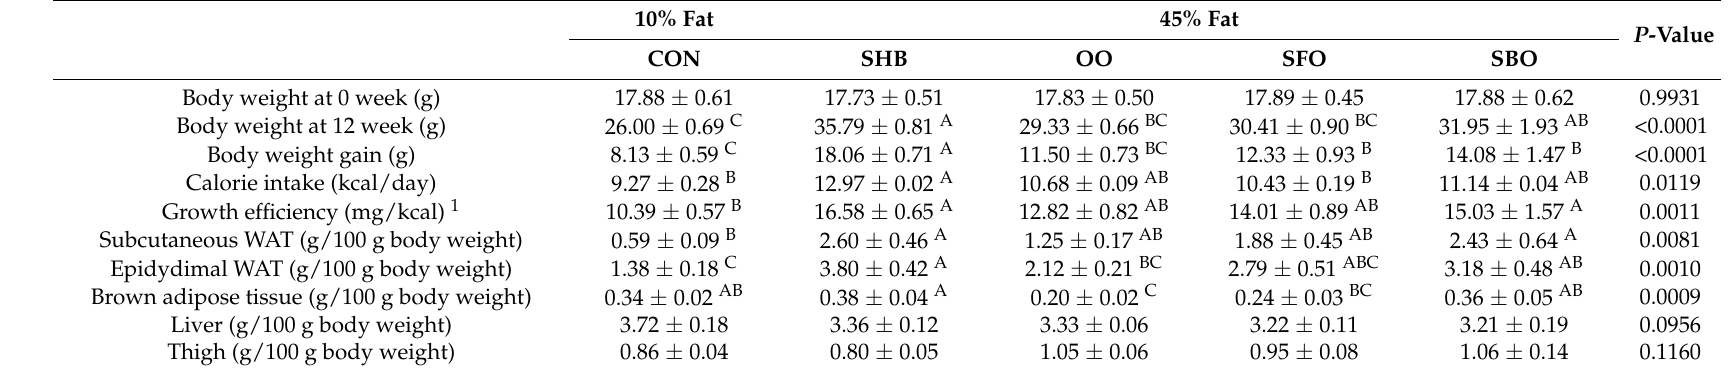
Table 2. Body weight, calorie intake, growth efficiency, and tissue